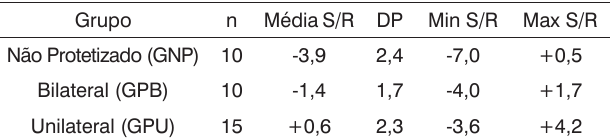
Tabela 5. Média da relação S/R (campo livre) e desvio padrão (DP) no teste LSP para os três grupos (em dB). Valores Mínimos (Min) e Máximos (Max) são disponibilizados.